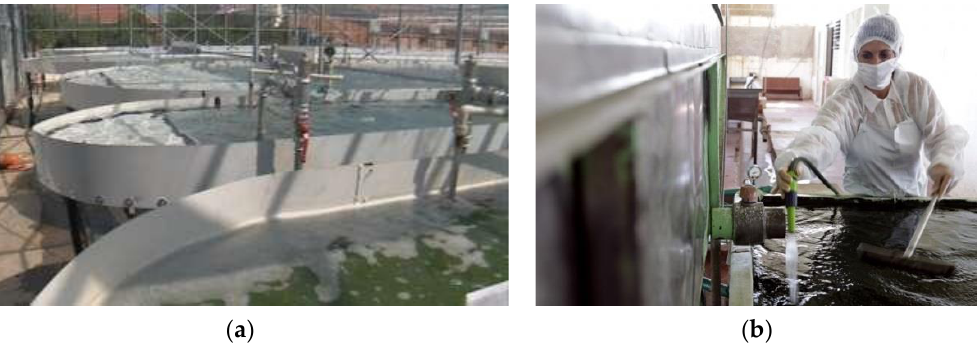
Figure 1. Bioreactor in Varvara, Bulgaria ( a ) condions into the reactor; ( b ) production of biomass .